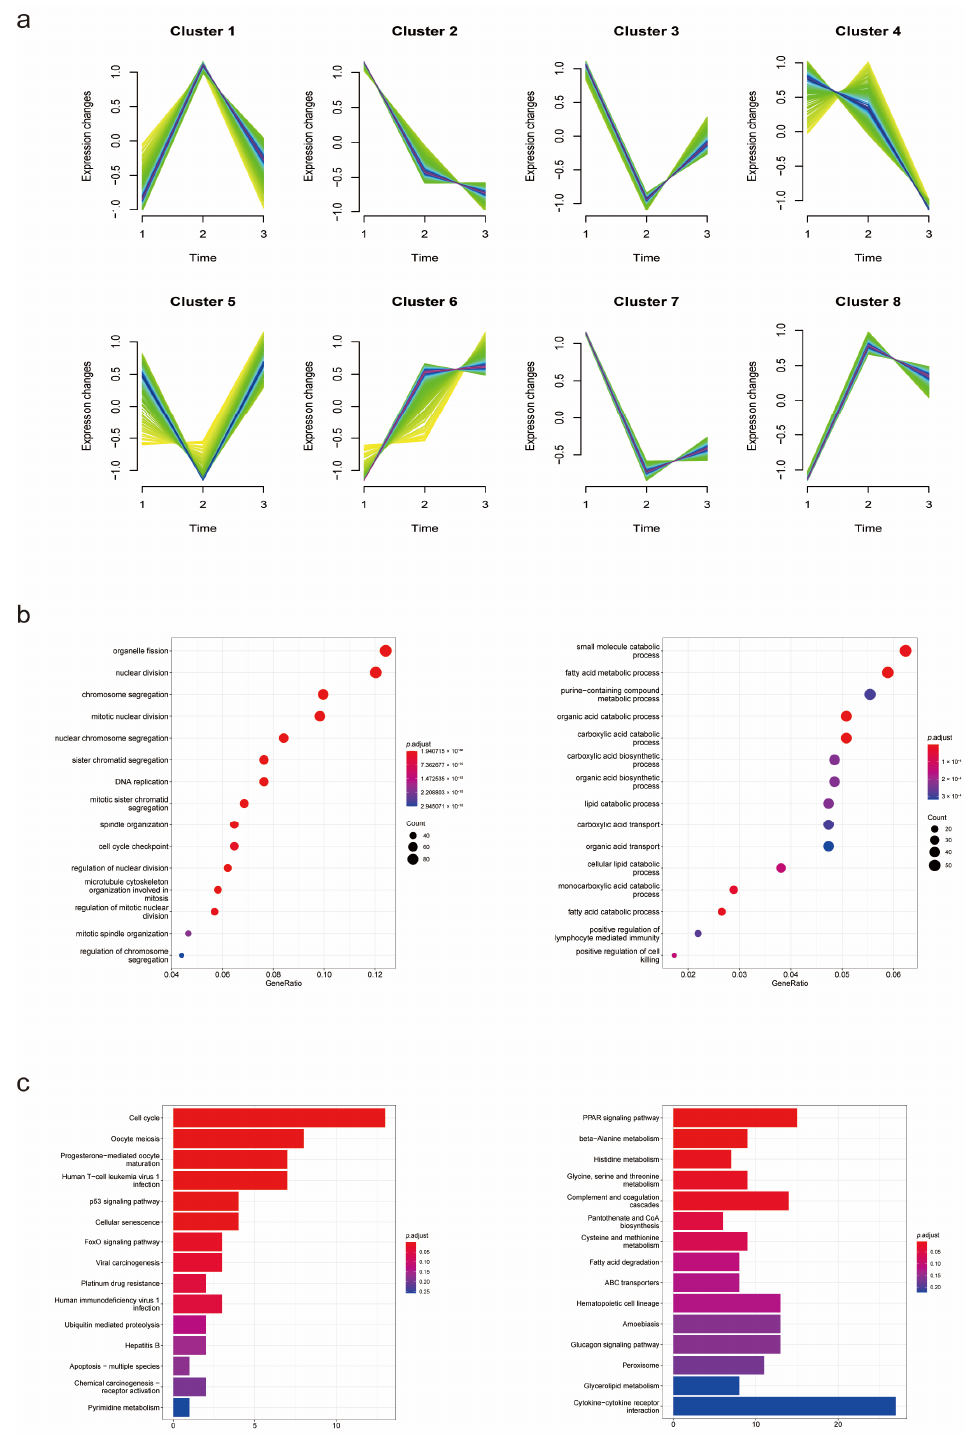
Figure 3. Mfuzz cluster and enrichment analyses of overall DEGs. ( a ) Mfuzz cluster analysis illustrated the changes in mRNA expression in the process of HCC development. ( b , c ) GO and KEGG enrichment analyses revealed potential functions of the DEGs and critical pathways in disease progression.